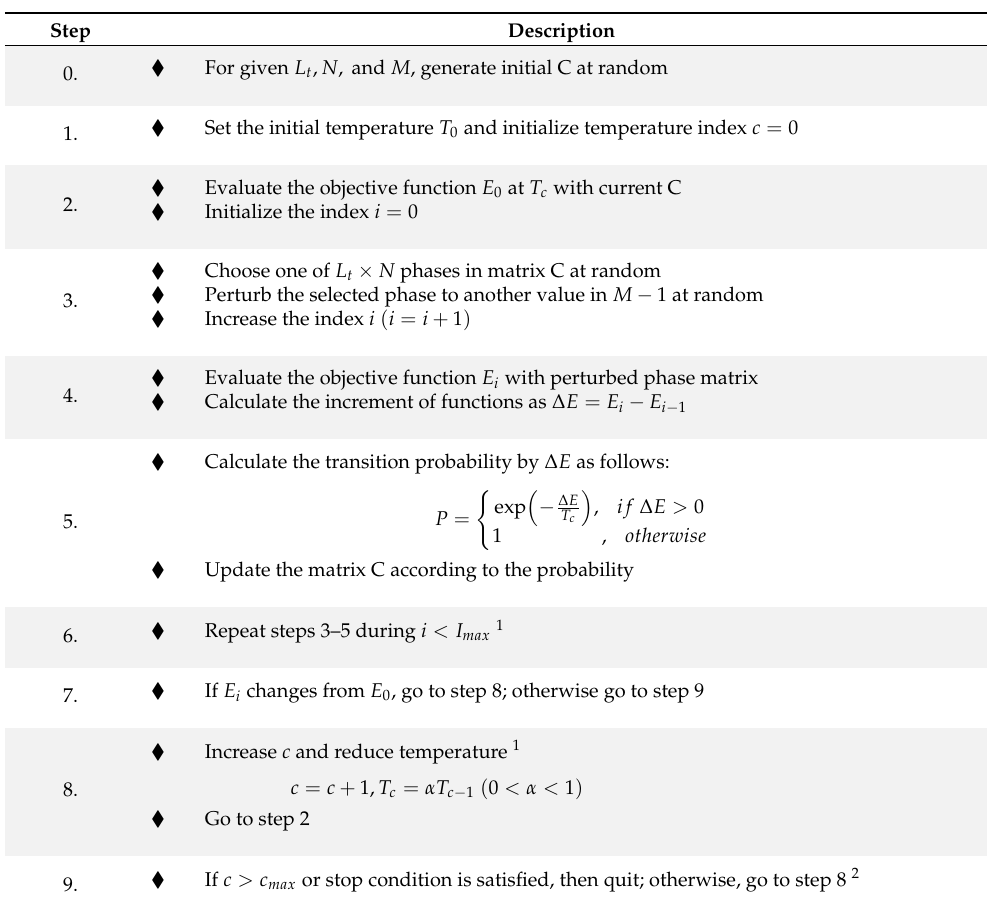
Table 1. Process of polyphase codes design using SA